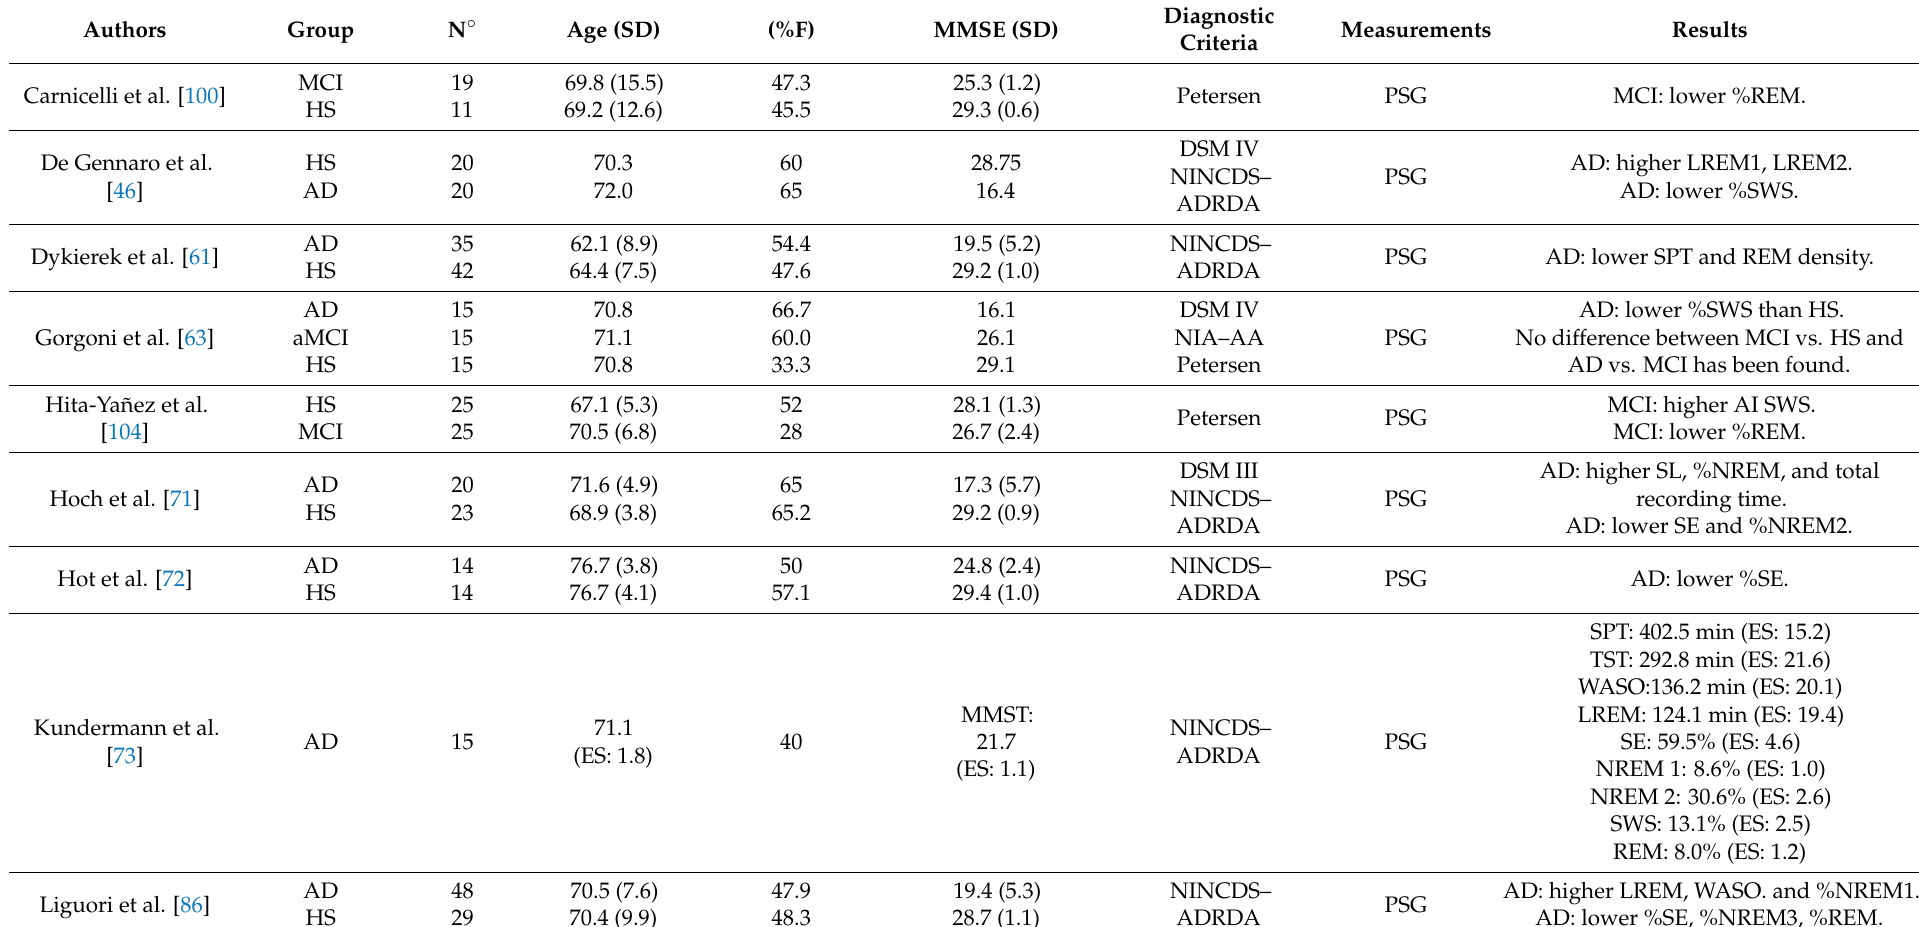
Table 6. Sleep in pathological older age. Summary of all the studies that use